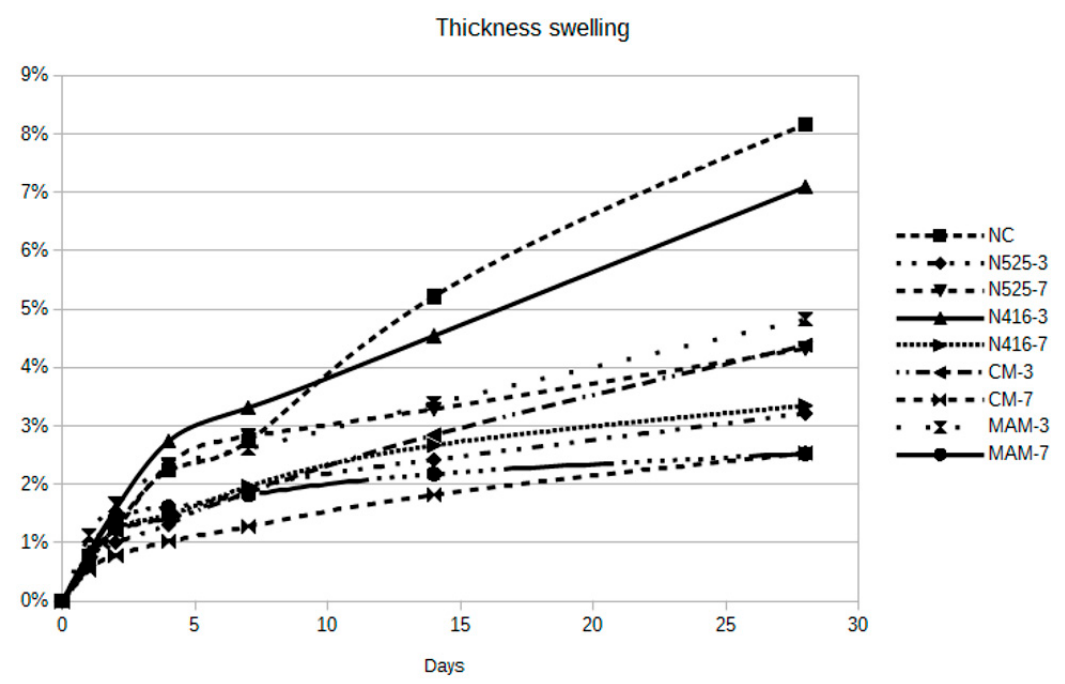
Figure 5. Thickness swelling of the materials in immersion.